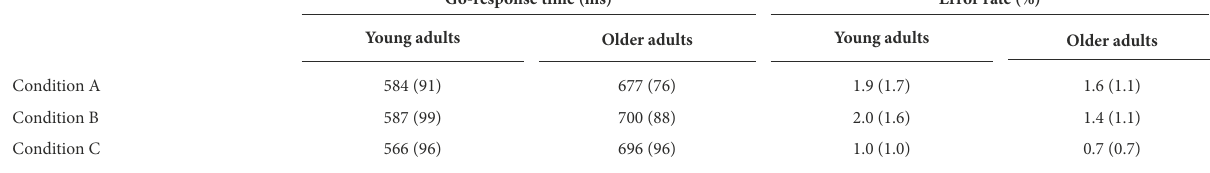
TABLE 1 Means and standard deviation of response times and error